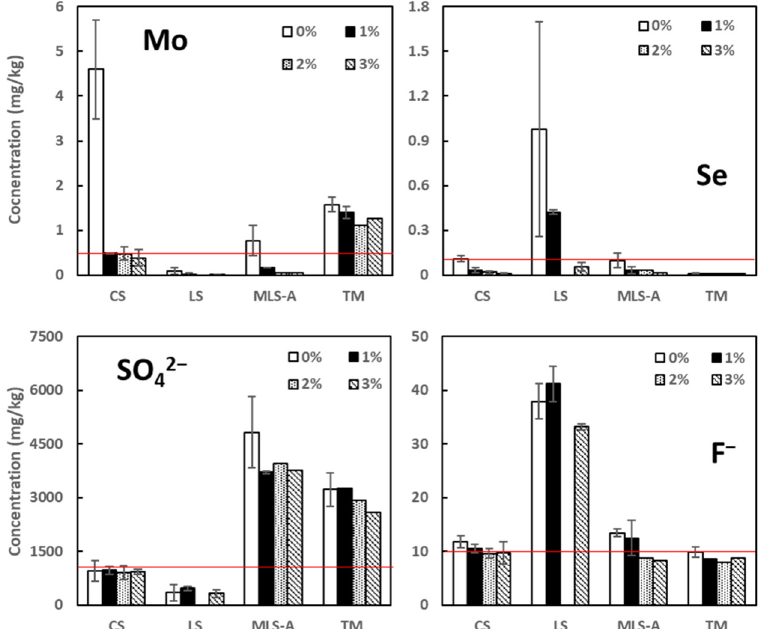
Figure 5. Concentrations of Mo, Se, sulfates and fluorides in the leachates of batch leaching tests [37] as impacted by the percentage of zero valent iron added in CS, LS, MLS-A and TM. If no bars are presented for a given percentage, then this percentage has not been tested for the sample concerned. Red horizontal lines refer to the IWL threshold value.